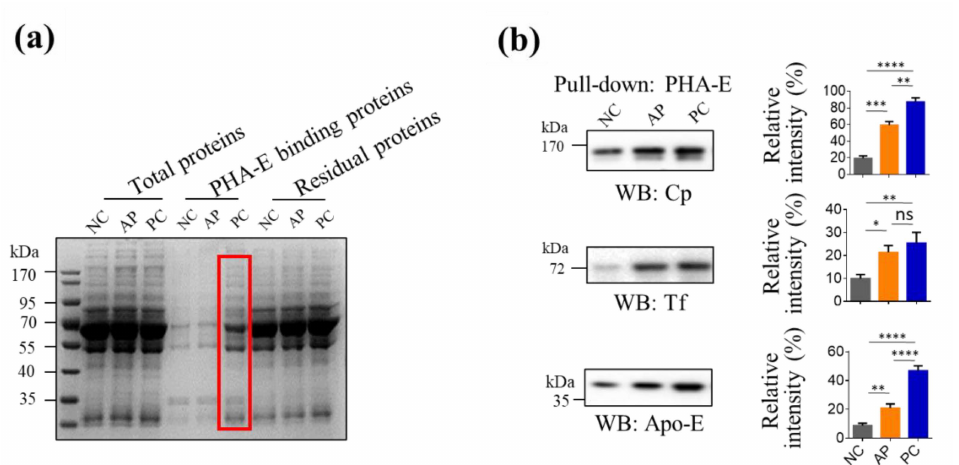
Figure 3. Detection of bisecting glycoproteins in PC patients’ sera. ( a ) PHA-E lectin pull-down and SDS-PAGE analysis. Serum proteins from NC, AP, and PC groups were treated with TCA to remove albumins and then 350 µ g proteins were employed to perform pull-down experiment with PHA-E overnight at 4 ◦ C. Then, the mixture was incubated with streptavidin-agarose and the exacted proteins and residual proteins were analyzed by SDS-PAGE. An amount of 6 µ g of total proteins, 20 µ L of PHA-E binding proteins, and 6 µ g of residual proteins for each sample was loaded onto the gel. Protein bands differently expressed in PC group as compared to NC and AP groups (indicated by red frame) were cut and extracted for LC-MS analysis. ( b ) The expression levels of Cp, Tf, and Apo-E in PHA-E-precipitated proteins among pooled sera of NC, AP, and PC were analyzed by Western blotting (left). Twenty milliliters of PHA-E-precipitated proteins of each group was loaded onto the gel. The relative intensities of bands were analyzed by Image J software, normalized with total protein signal in CBB staining of the first three lines in (a), and finally statistically analyzed by Graphpad Prism 6.0 (right). The values are means ± SD (error bars) from three independent experiments. NC, normal control; AP, acute pancreatitis; PC, pancreatic cancer; Cp, ceruloplasmin; Tf, transferrin; Apo-E, apolipoprotein E; WB, Western blotting; *, p < 0.05; **, p < 0.01; ***, p < 0.001; ****, p < 0.0001; ns, no significant